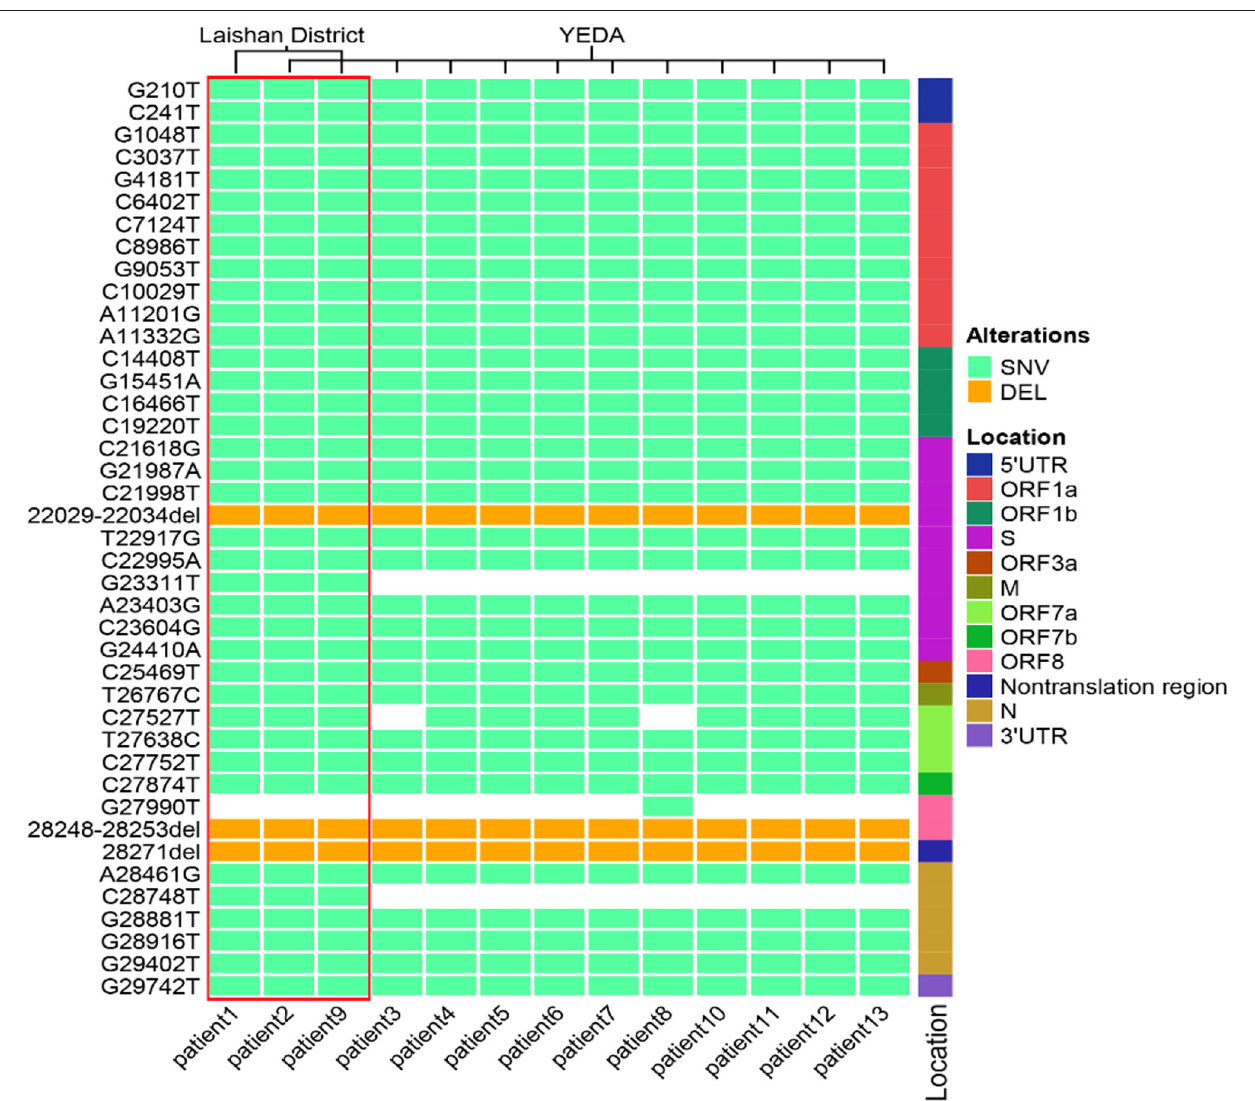
FIGURE 2 | The mutation spectrum of 13 SARS-COV-2 sequences in Yantai. These mutation sites are based on the alignment between the whole genome sequence of the virus and the reference genome. All sites were sorted according to their positions in the genome. The location represents the position of the mutation site in the genome. The pale green box represents SNV, the orange box represents DEL and the white box represents no mutation at this site. The red box contains three patients within the same transmission route.